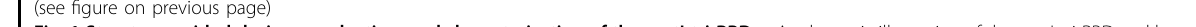
Fig. 1 Structure-guided design, production, and characterization of the mutI-tri-RBD. a A schematic illustration of the mutI-tri-RBD and homo- tri-RBD design schemes. The RBD region comprising the residues 319 – 537 was truncated from the S protein, and three truncated RBDs were connected end-by-end to construct the trimeric forms of RBD. In mutI-tri-RBD, three RBDs were individually derived from three different circulating SARS-CoV-2 strains, i.e., the prototype, Beta and Kappa. In homo-tri-RBD, the three RBD units were all truncated from the prototype strain. In the upper sub fi gure, the S1 and S2 subunits of the S protein, as well as NTD, RBD, SD1, and SD2 in the S1 subunit, are marked. The lower sub fi gure displays the natural trimeric arrangement of RBDs in the native structure of S trimer. The arrows indicate the direct connections of the N- and C- terminals between different RBDs. b Structural modeling and MD simulation of the designed homo-tri-RBD (upper sub fi gure) and mutI-tri-RBD (lower sub fi gure). Time-evolution of the C α root-mean square deviation (RMSD) of the modeled structure during MD simulation, as well as several snapshot conformations in the simulation, is displayed. c SDS-PAGE pro fi les of increasing amounts of the recombinant mutI-tri-RBD and homo-tri-RBD proteins expressed by HEK293T cells. d Molecular weight of mutI-tri-RBD determined by MALDI-TOF MS. e Molecular weight of mutI-tri-RBD after deglycosylation determined by UPLC-MS. f Secondary structure contents of mutI-tri-RBD protein analyzed by circular dichroism spectrometry. g Left: the proportions of free sulfhydryl for all the cysteine residues in mutI-tri-RBD. Right: the disul fi de linkages in the recombinant mutI-tri-RBD protein detected by liquid chromatography-mass spectrometry. Only the disul fi de bonds in one RBD unit are listed. h Differential scanning calorimetry thermograms of the recombinant mutI-tri-RBD protein. i The binding capability of the designed mutI-tri-RBD and homo-tri-RBD proteins with two anti-RBD monoclonal nAbs, i.e., MM43 and R117, evaluated by ELISA. As controls, the binding activities with the monoclonal nAbs for the monomeric his-tagged RBDs from the prototype, Beta, and Kappa SARS-CoV-2 strains were also measured. j The binding pro fi les of the recombinant mutI-tri-RBD with hACE2 detected by surface plasmon resonance